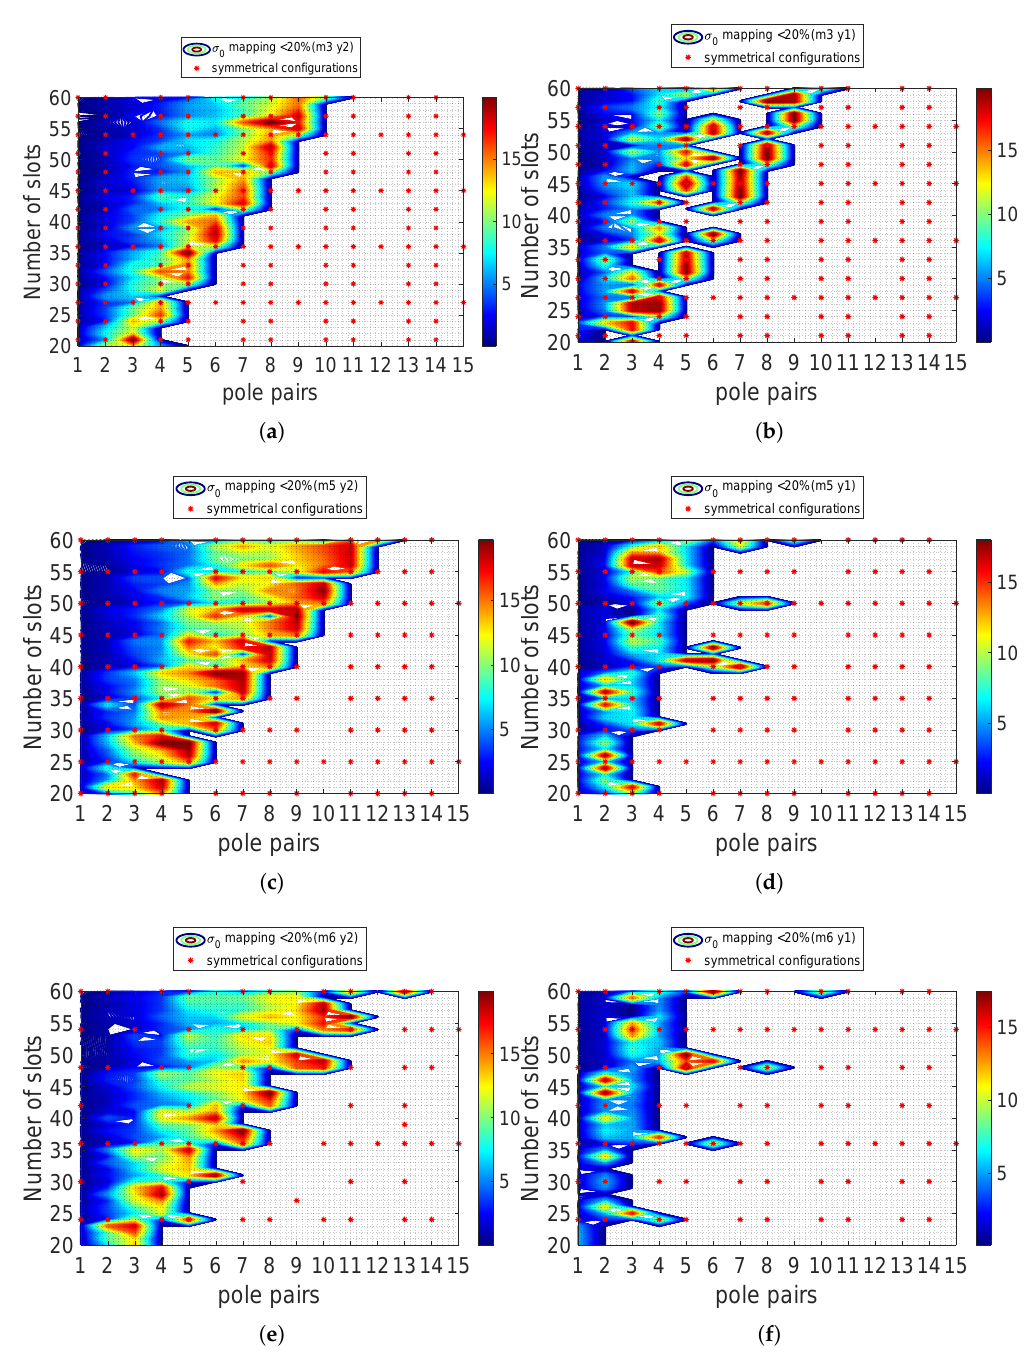
Figure 3. Mapping of the leakage factors for all the proposed combinations: ( a ) m = 3, y = 2, ( b ) m = 3, y = 1, ( c ) m = 5, y = 2, ( d ) m = 5, y = 1, ( e ) m = 6, y = 2 and ( f ) m = 6, y =